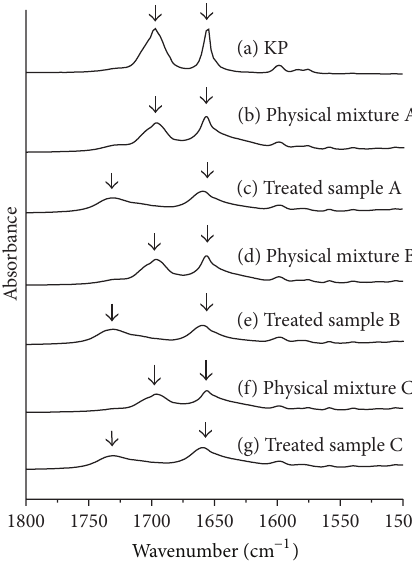
KP, KP:Me 𝛽 CD physical mixtures and samples treated in scCO 2 at 40 ∘ C, 20 MPa, 1h: (a) pure KP, (b) physical mixture A (16.3% KP), (c) treated sample A (16.3% KP), (d) physical mixture B (18.7% KP), (e) treated sample B (18.7% KP), (f) physical mixture C (13.8% KP), and (g) treated sample C (13.8%